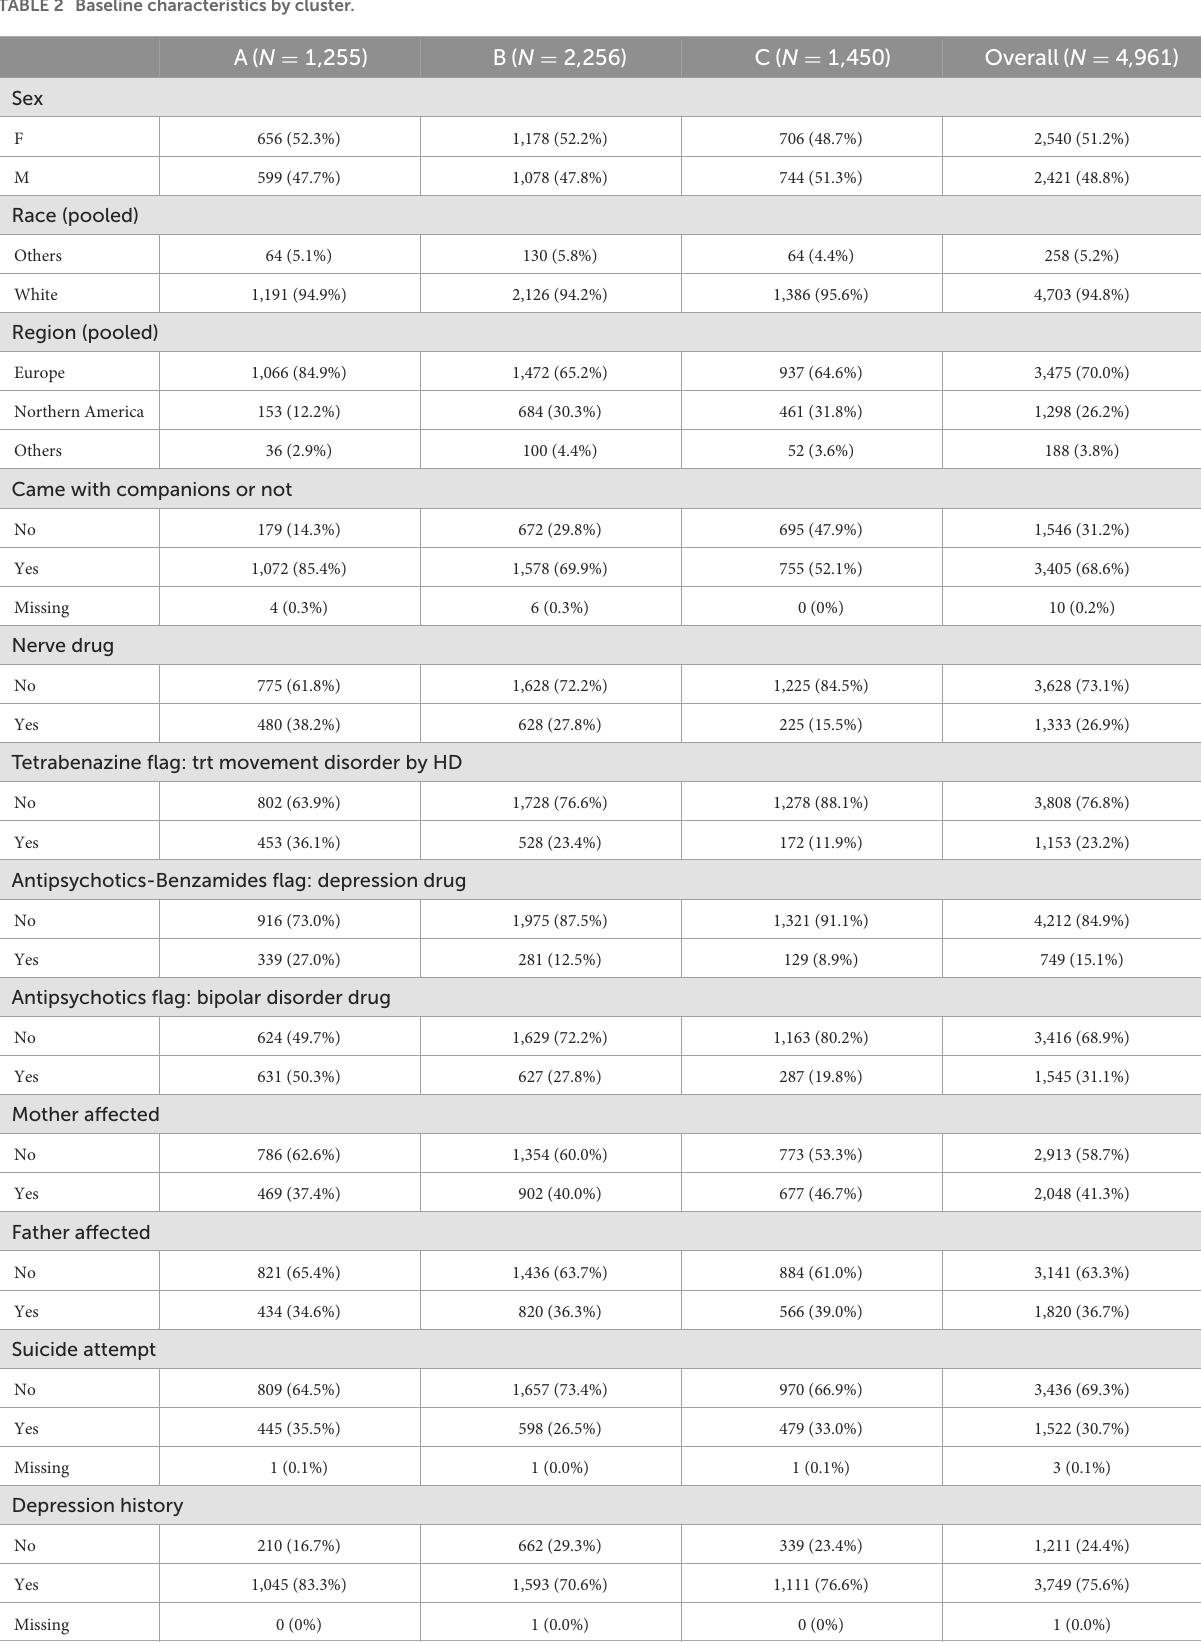
TABLE 2 Baseline characteristics by